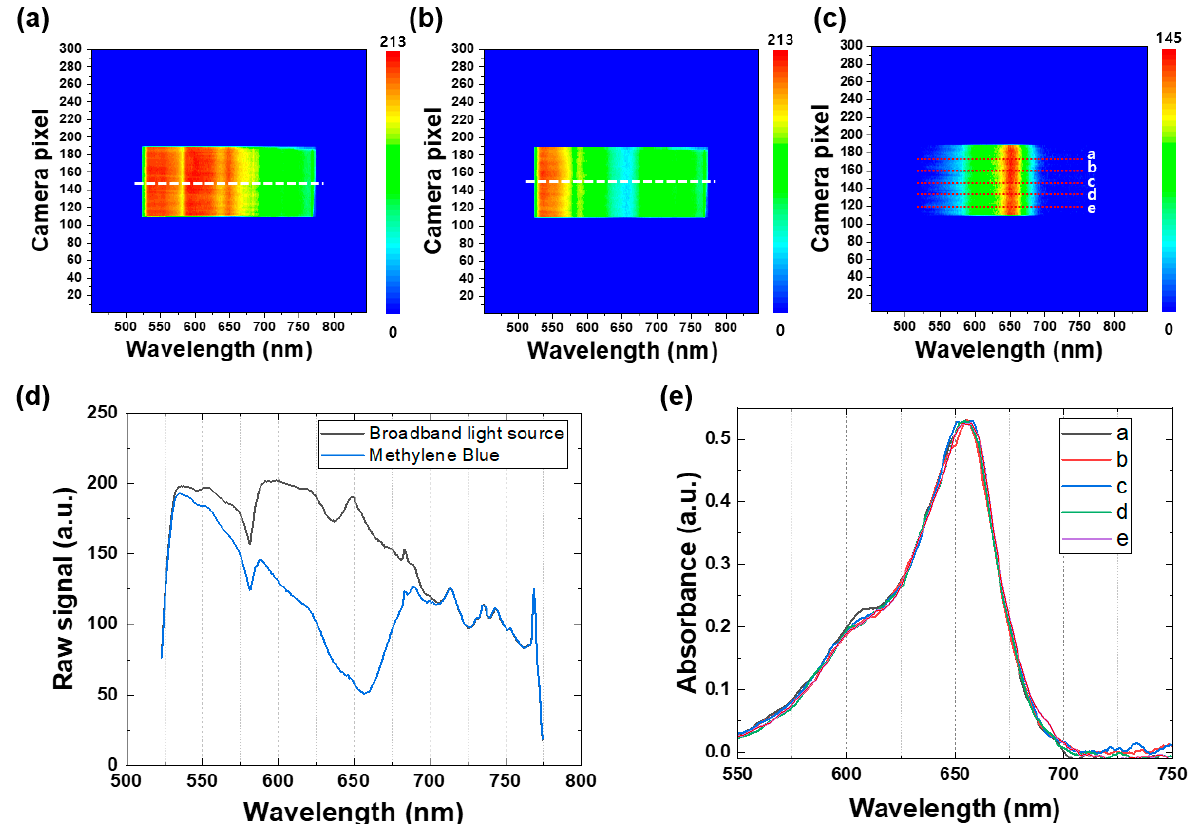
Figure 4. Representative contour maps of the broadband light source when the light passes through ( a ) the reference sample (TiO 2 nanoparticles in ethanol) and ( b ) the MB sample. ( c ) A representative absorbance contour map of the MB sample obtained by subtracting the contour map of the reference broadband light source. ( d ) Raw spectra extracted from the white do tt ed lines in the contour maps of the broadband light source ( a , b ) as the reference signal (black line) and the MB sample (blue line). ( e ) Absorbance spectra of the MB sample extracted from fi ve di ff erent white do tt ed lines in the absorbance contour map ( c ).